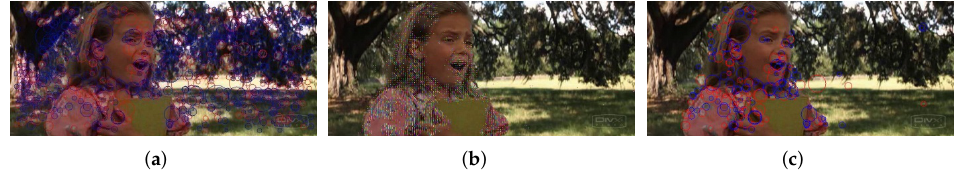
Figure 12. Illustration of the initial filter of SURF points by optical flow field. ( a ) Initial SURF points. ( b ) Initial optical flow field. ( c ) Initial filter by optical flow field.